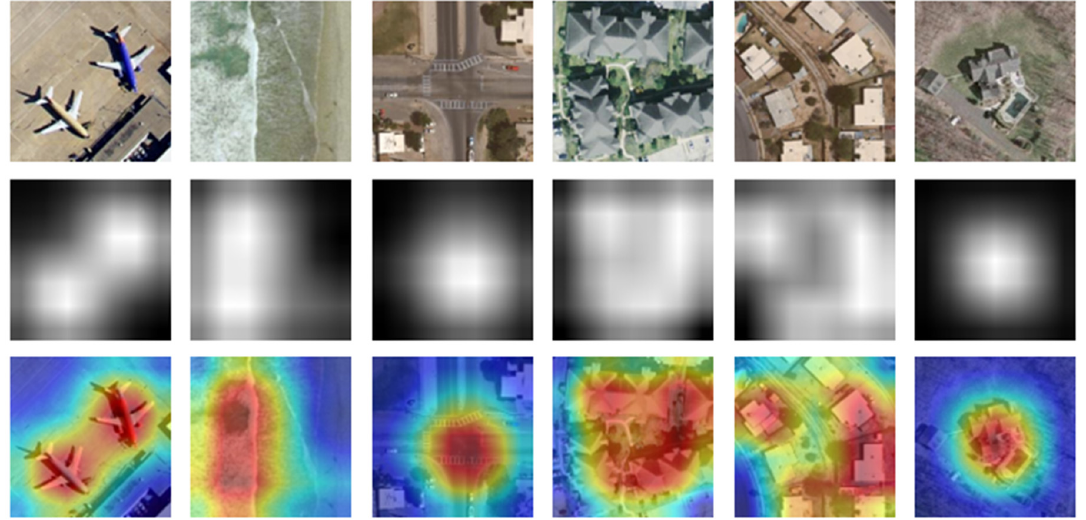
Figure 10. Saliency mask results. The Grad-CAM visualization is calculated for the last convolutional layers. Each input image is shown in the first line, where saliency images and attention maps are shown in the second and third line, respectively.